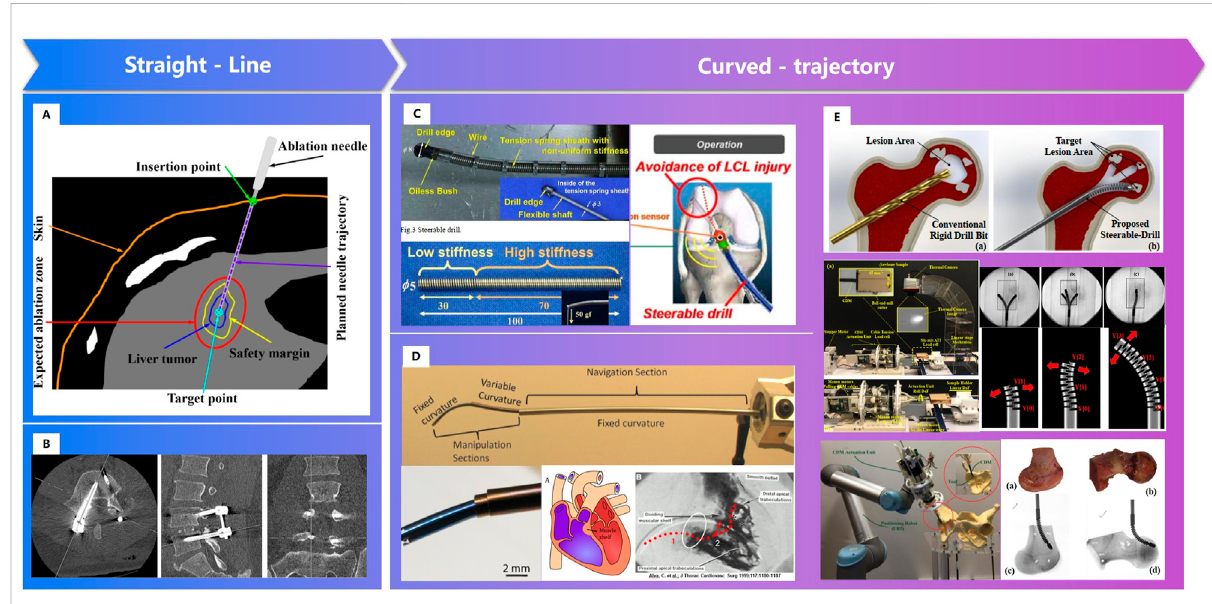
FIGURE 12 Surgical channels constructed by robot. (A) . Straight needle trajectory planning for radiofrequency ablation and microwave ablation of liver tumors (Zhang et al., 2019). (B) . Linear surgical channel for spinal screw internal fi xation (Nicolas et al., 2016). (C) . A “ Steerable Drill ” for ACL Reconstruction to Create the Arbitrary Trajectory of a Bone Tunnel (DePhillipo et al., 2018). (D) . Endoscopic Add-on Stiffness Probe (Gilbert et al., 2014). (E) . A less-invasive surgical workstation to treat osteolytic lesions behind a well- fi xed acetabular implant (Bakhtiarinejad et al., 2020)- (Alambeigi et al.,